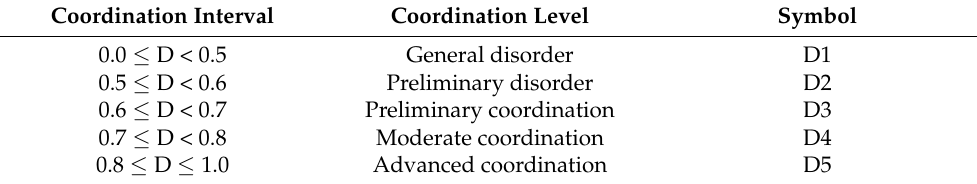
Table 3. Classification criteria for coordination. Coordination Interval Coordination Level Symbol 0.0 ≤ D < 0.5 General disorder D1 Preliminary disorder D2 Preliminary coordination D3 Moderate coordination D4 Advanced coordination